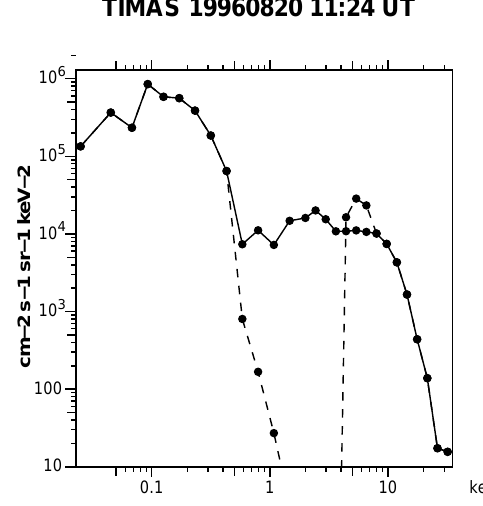
Fig. 6. Application of the sharpening procedure to TIMAS data (0 − − 30 ◦ pitch angle) taken on 20 August 1996, 11:24UT (MLT 3.4, ILAT 69, R 4.1 R E ) in the Northern Hemisphere. Solid line is the original distribution and dashed line the sharpened version. A plateau exists between 1 and 10keV that the procedure has found and replaced by a shell distribution, conserving the number of par- ticles. The plateau is not completely smooth in this case, but this does not harm the sharpening